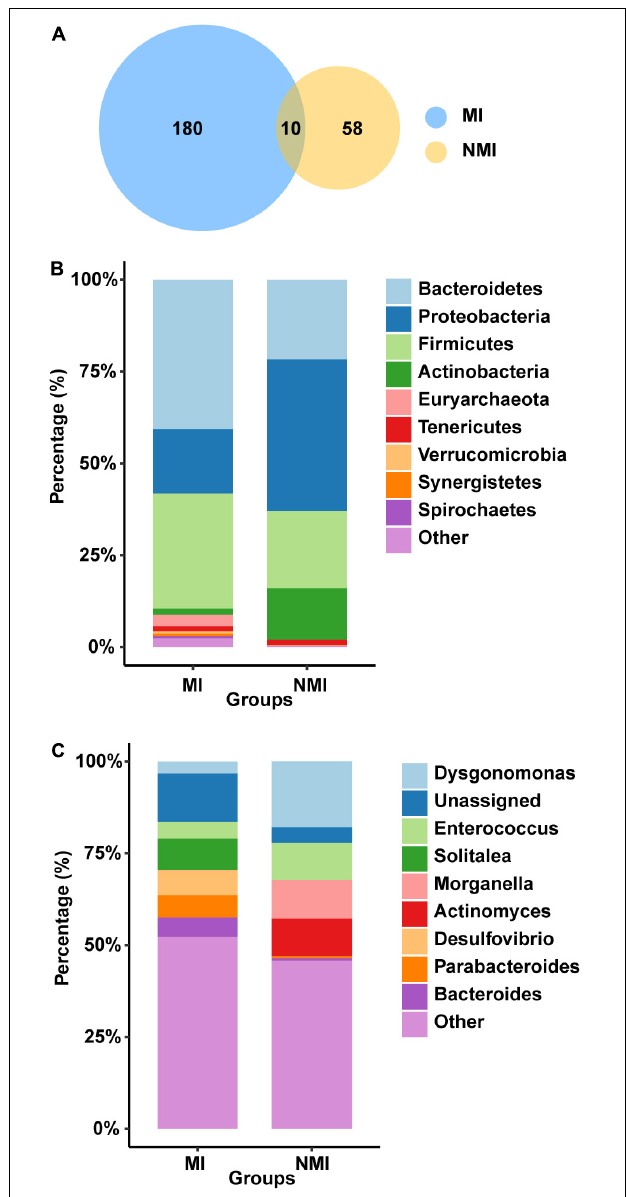
FIGURE 2 | Differences of gut microbiota between medicinal insect group (MI) and non-medicinal insect group (NMI) at the OTU level and phylum/genus level. (A) Venn diagram based on OTUs. There were a total of 190 and 68 OTUs in the MI and NMI groups, respectively, of which 10 OUTs overlapped in both groups. (B) Histogram of the relative abundance of the 10 most abundant phyla in the gut microbiota of the MI and NMI